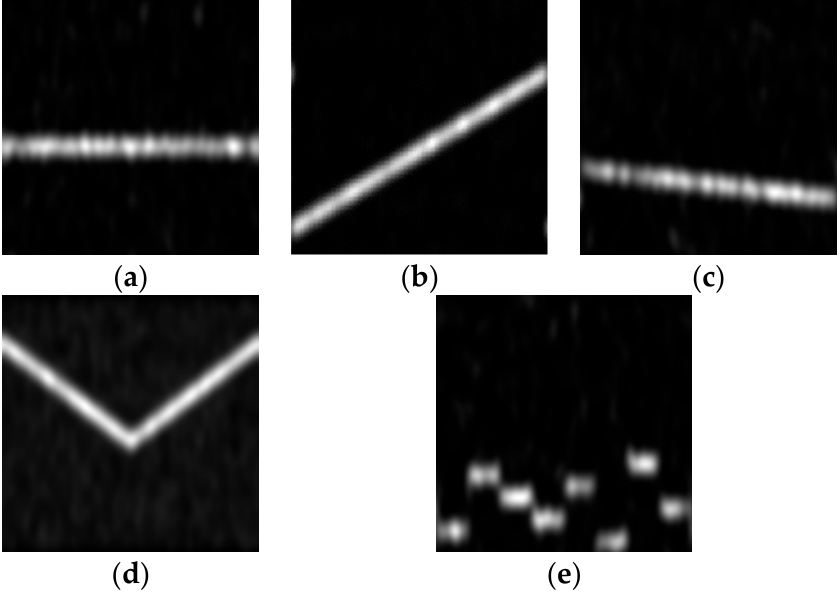
Figure 6. Generated SPWVD of radars’ waveform (0 dB): ( a ) Radar A; ( b ) Radar B; ( c ) Radar C; ( d ) Radar D; ( e ) Radar E.